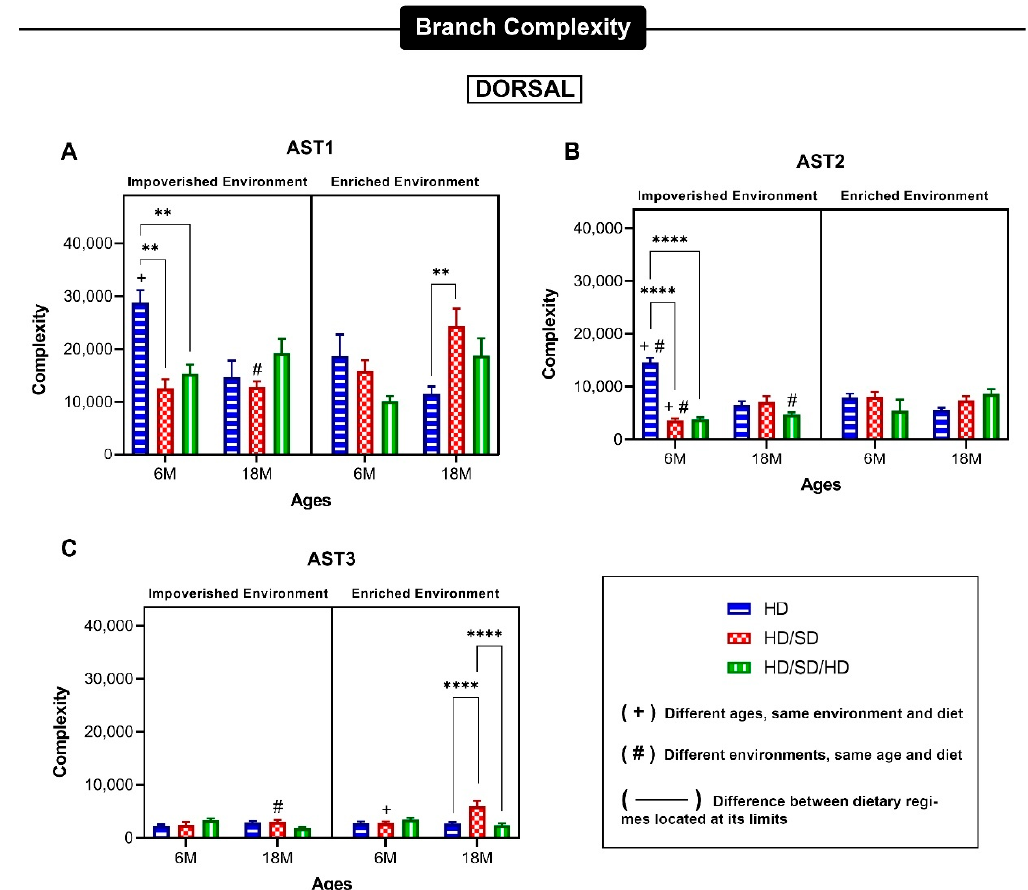
Figure 6. Mean values of astrocyte morphological phenotypes based on branch complexity at the external one-third of the molecular layer of the dorsal dentate gyrus. ( A – C ): Mean values of branch complexity and corresponding standard errors of astrocyte arbors to illustrate morphological differences between AST1 ( A ), AST2, ( B ) and AST 3 ( C ) for each experimental group based on impoverished environment and enriched environment, age (6M—6-month-old; 18M—18-month-old) and masticatory regimen (HD, HD/SD, and HD/SD/HD). HD: hard diet/pellet; SD: soft diet/powder food; * p < 0.05, ** p < 0.01, *** p < 0.001 and **** p < 0.0001; ns, not significant, by three-way ANOVA.